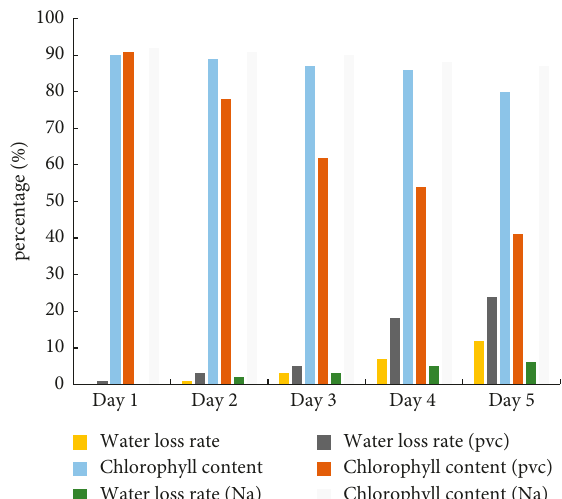
Figure 6: Schematic diagram of the experimental results of veg- etable preservation based on the ozone micro-nano bubble pres- ervation